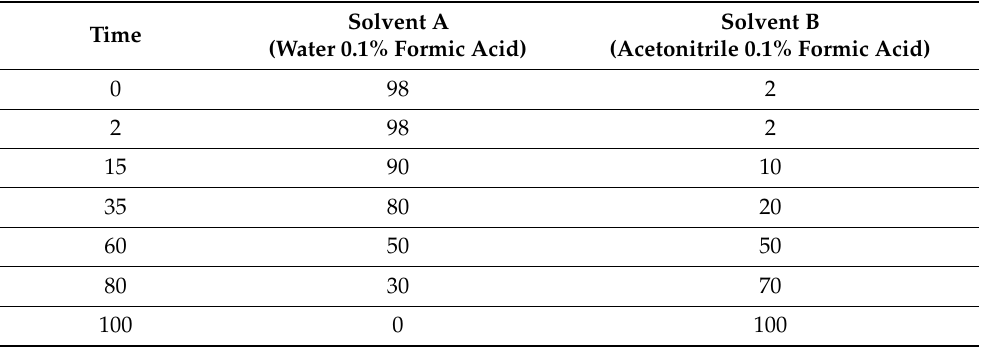
Table 7. Elution profile used in polyphenols